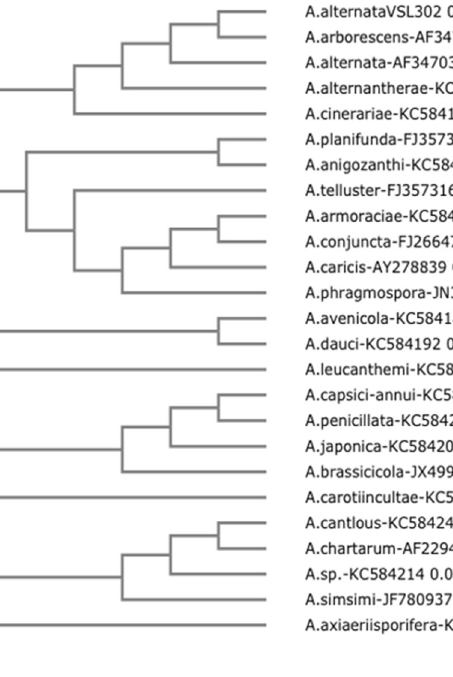
concentrations against F. solani . Vegetable specie, R = roots and solvent methanol (MeOH) or ethylacetate (AcOEt) are indicated by abbreviations between parenthesis. Different responses observed at three concentrations are marked ( ∗ ) (Tukey; P = 0 . 05). Azo; azoxystrobin